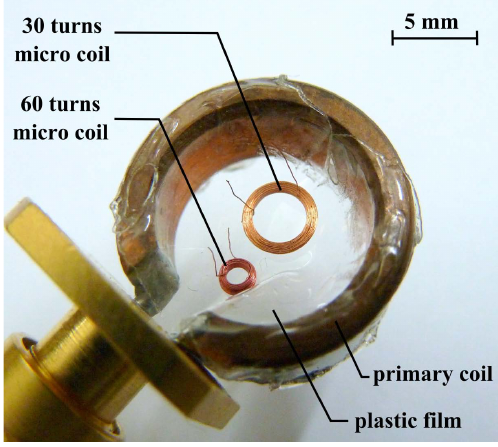
Figure 12. Simultaneous wireless measurement of two di ff erent open-ended micro coils placed inside electrically small loop an-